Question: Briefly state, in one sentence, what is plotted here.
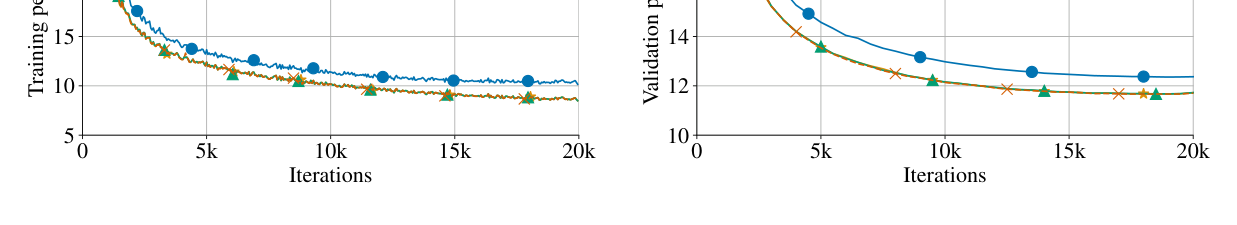
Answer: Pretrainnig progress for GPT 1.3B with settings described in Section 5.2 and global batch-size=512, β2 = 0.95. Left: training perplexity vs iterations, and right: validation perplexity vs iterations for different precision strategy listed in Table 2. The proposed COLLAGE formations consistently match the FP32 master weights with much less memory footprint and faster training.